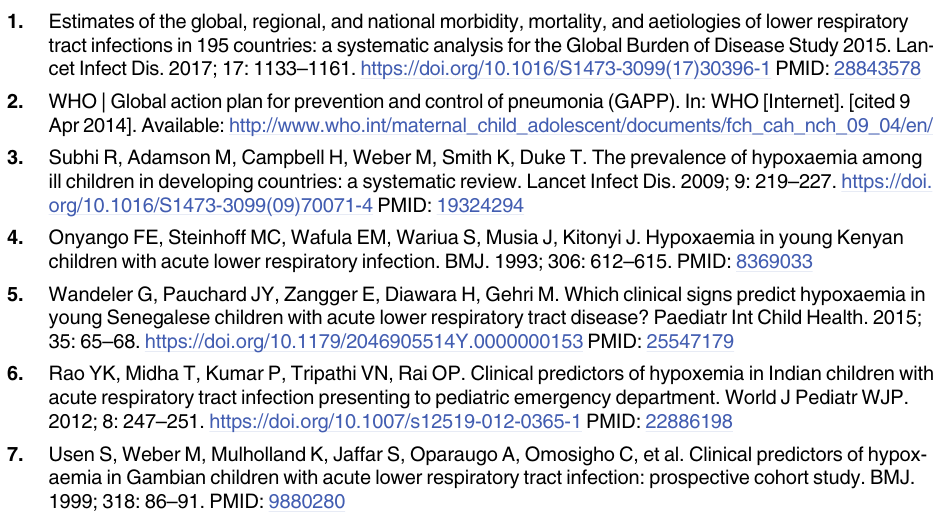
S2 Table. Severe pneumonia among all pneumonia episodes. Se: sensitivity, Sp: specificity,